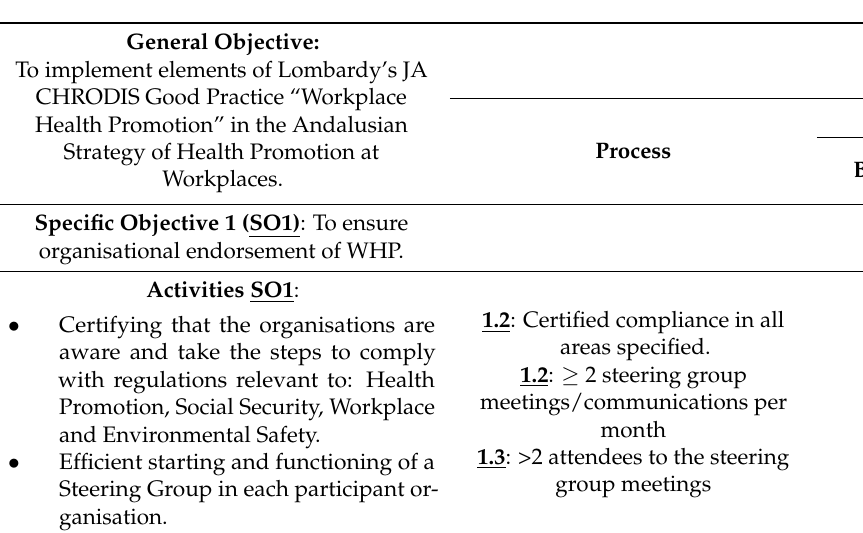
Table 3. Main outcomes of the Pilot Action Plan (after 9